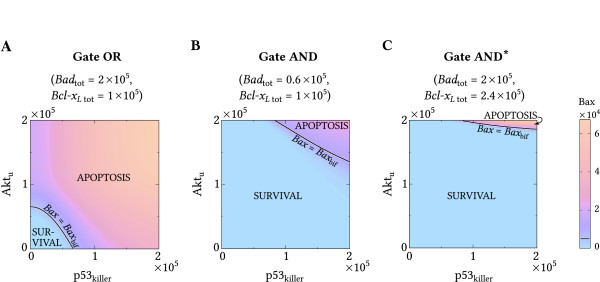
Bax in the input signals (p53killer, Aktu)-plane for three considered logic gates. (A) gate OR, (B) gate AND, (C) gate AND*. For all gates the black curve is the apoptotic isoline Bax = Baxbif = 5000. For values of Aktu and p53killer above the Bax = Baxbif isoline cell undergoes apoptosis, for values of Aktu and p53killer below this curve cell survives.